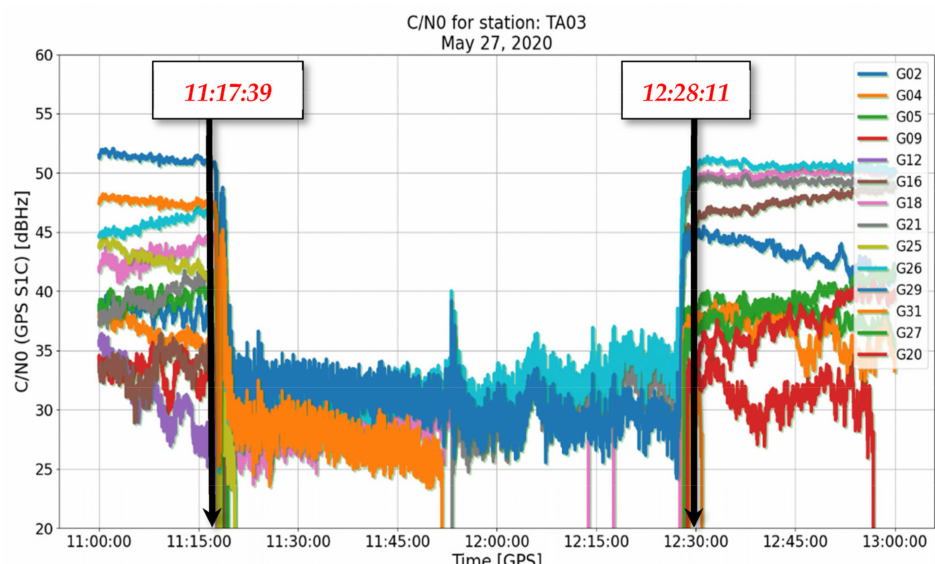
Figure 4. C/N 0 values for GPS L1 observations during Case 1, an L1 jamming incident registered at TA03. The incident lasts approximately 1 h and 10 min (from 11:18 to